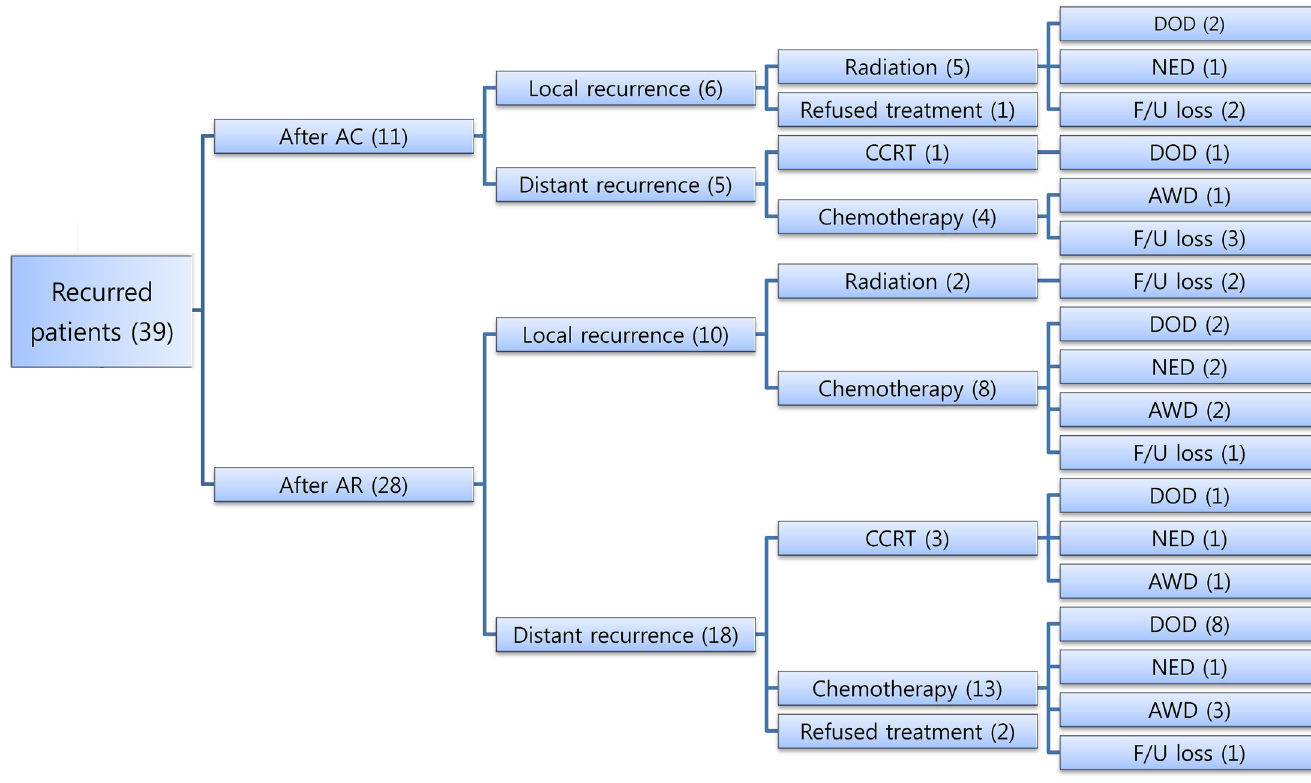
Fig 3. Salvage treatment and final status of the recurred patients (n = 39). AC: adjuvant chemotherapy; AR: adjuvant radiotherapy of concurrent chemoradiation; CCRT: concurrent chemoradiation; DOD: die of disease; NED: no evidence of disease; F/U: follow-up; AWD: alive with disease.